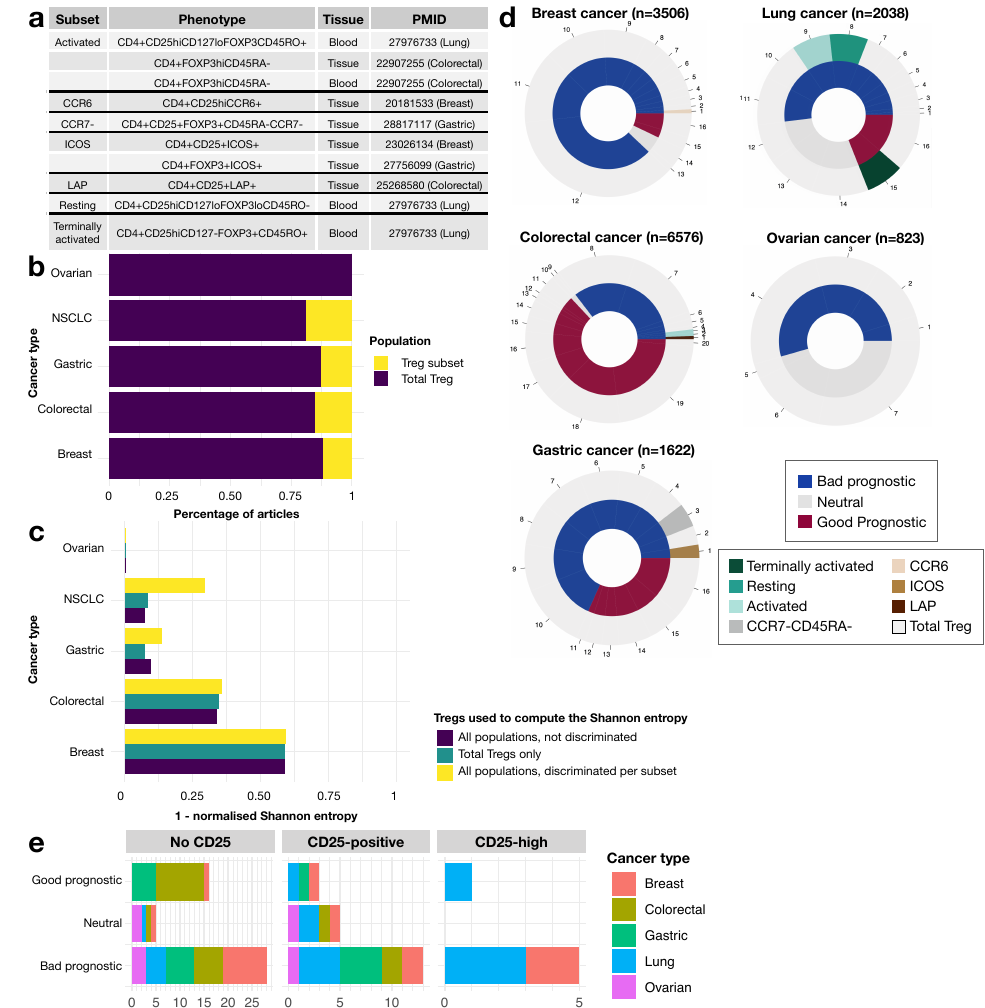
Figure 3. Subset diversity in cancer Tregs. ( a ) Summary of the various Treg subsets studied in the articles included in this meta-analysis. ( b ) Frequency of articles studying either the whole Treg population or a specific subset. ( c ) One minus the normalized Shannon entropy for each of the five cancer types, for all articles together (dark blue), articles focusing on the whole Treg population only (dark green), and mean of the entropies for each population type (yellow). ( d ) Pie chart of the prognostic impact of Tregs, as a function of the type of population used in the analysis, for each cancer type. Each numbered portion is an article and its size reflects the number of patients included in the study. ( e ) Bar plot of the prognostic value of Tregs in articles using CD25 high (right), CD25 + (middle), or no CD25 (left) to delineate